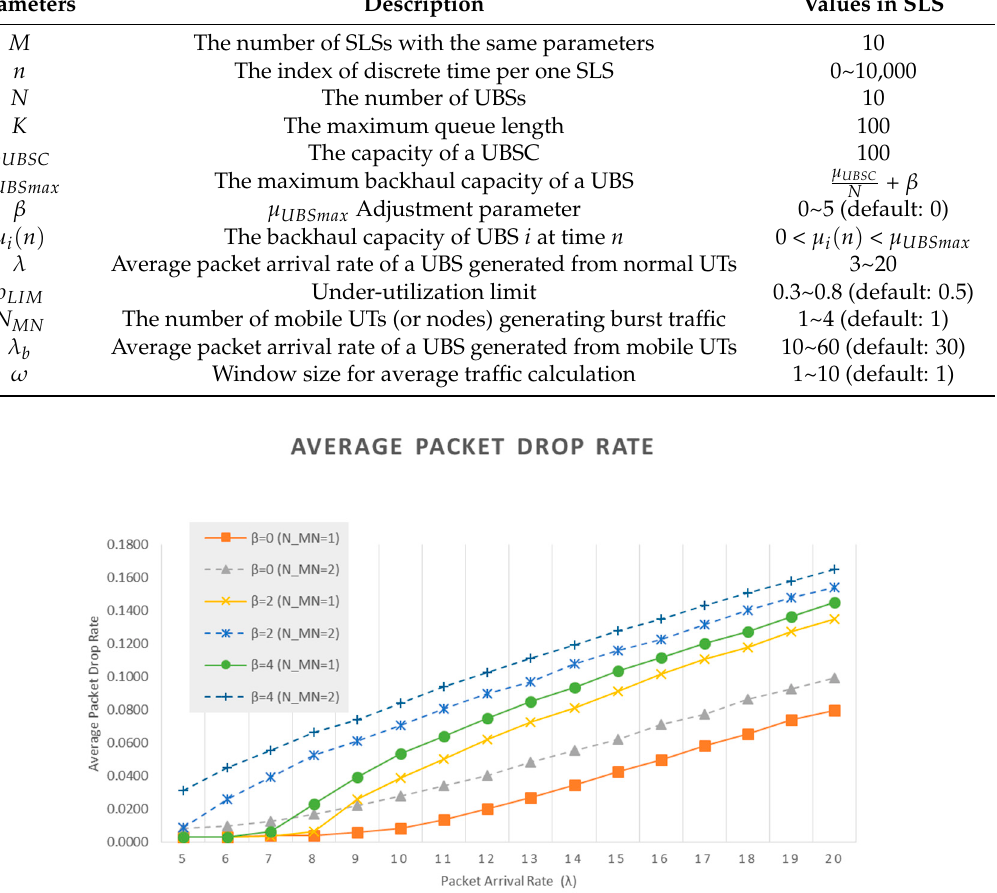
Figure 11. Average Packet Drop Rate for different µ UBSmax a djustment parameter ( β ) and the number of mobile UTs ( N MN )